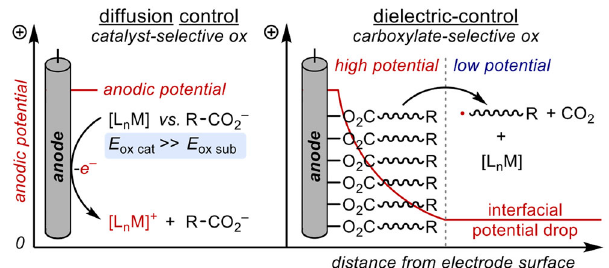
Fig. 2 Interfacial Potential. Interfacial potential drop at an anode with a self-assembled double layer of carboxylates. Table 1 Identi fi cation of mild conditions for Kolbe